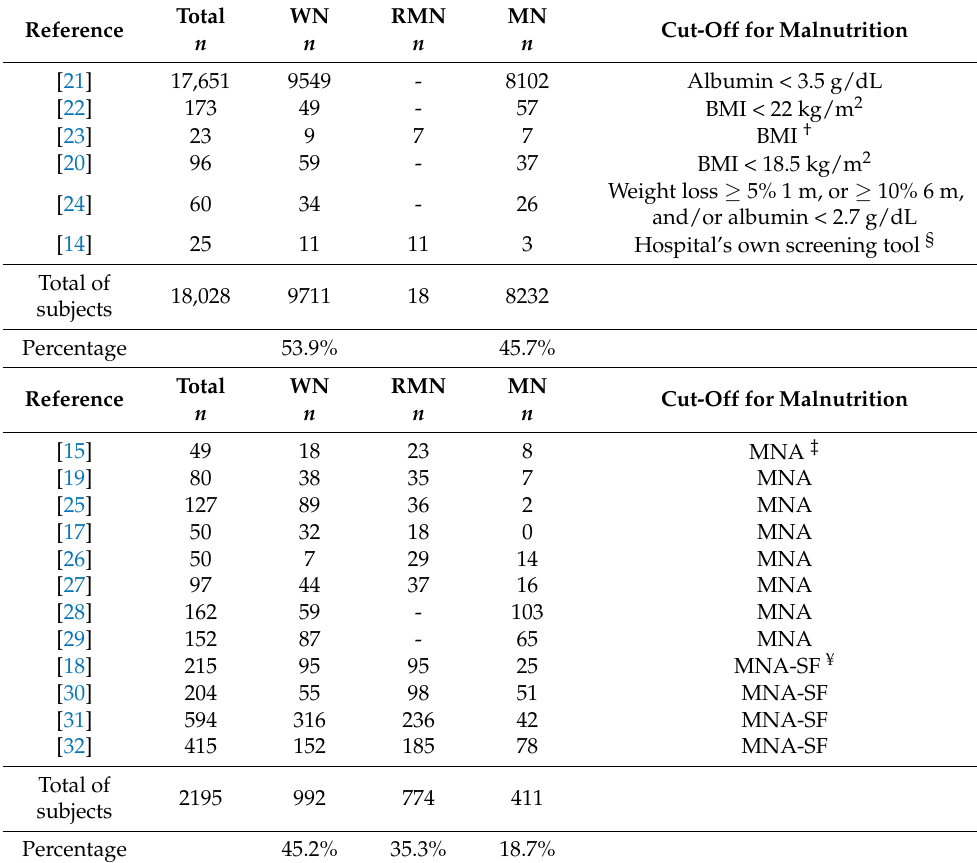
Table 1. Prevalence of malnutrition or risk of malnutrition and nutritional screening tool used in the included